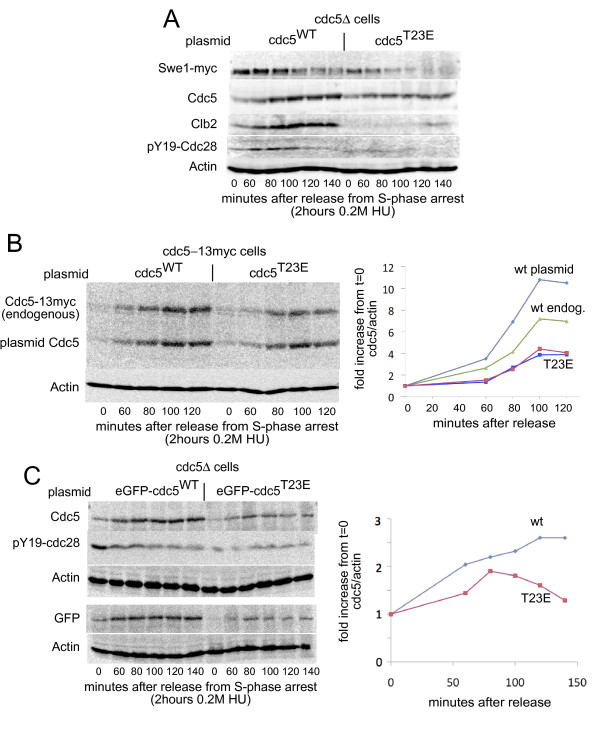
Phosphorylation of T23 regulates Cdc5 accumulation. A: cdc5Δ cells [3] expressing Cdc5WT or cdc5T23E [16] were synchronized in S-phase, released and rearrested at metaphase. B: Cdc5-13myc cells [3] expressing Cdc5WT or cdc5T23E [16] were synchronized in S-phase, released and rearrested at metaphase. C: cdc5Δ cells [3] expressing eGFP-Cdc5WT or eGFP-cdc5T23E were synchronized in S-phase, released and rearrested at metaphase.